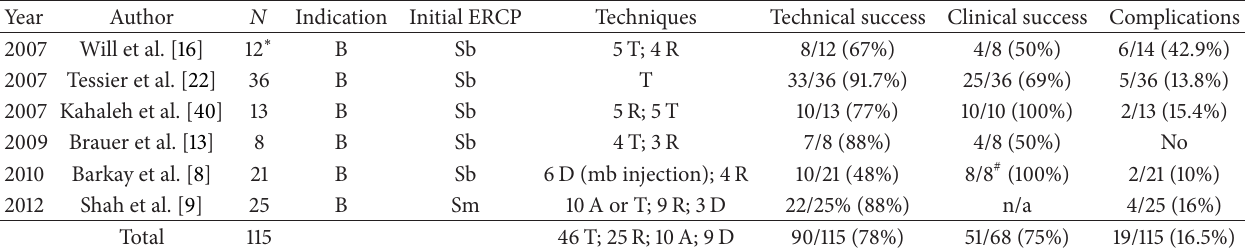
Table 4: Published EUS-CP series on pancreatic duct drainage (involving ≥ 5